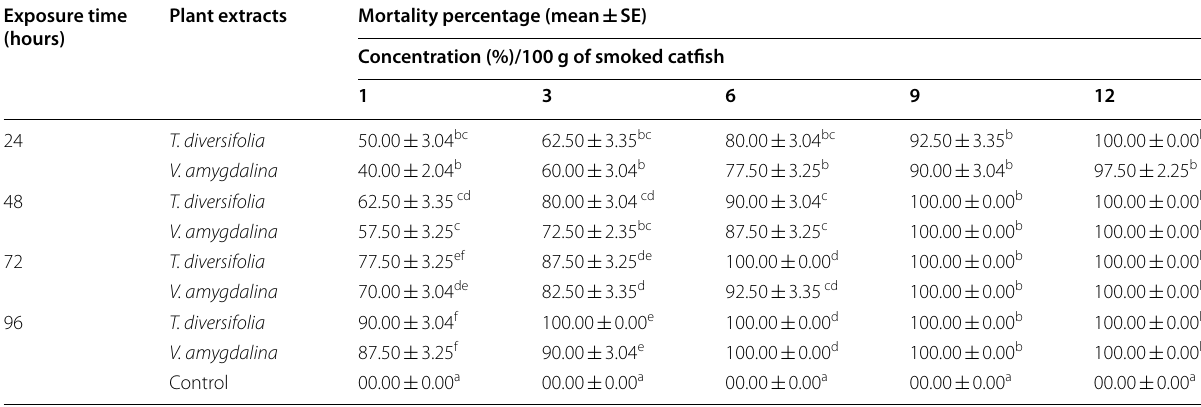
Mean followed by the same letters within the same column are not significantly different ( P >0.05)